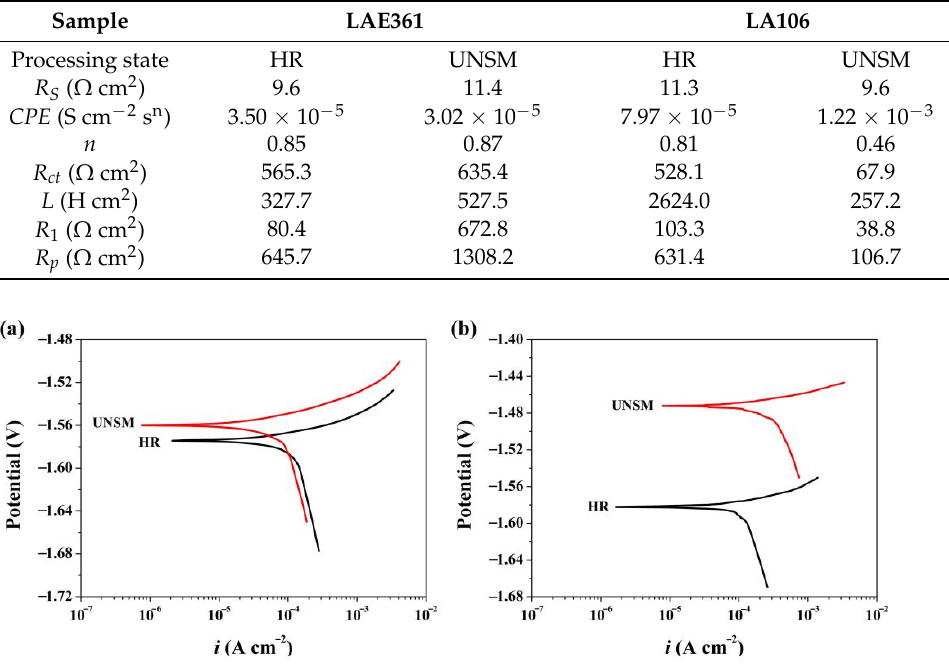
Figure 11. Nyquist plots of LAE361 Mg-Li alloy ( a ) and LA106 Mg-Li alloy ( b ) before and after the UNSM treatment in 3.5 wt.% NaCl solution at RT. Table 2. EIS parameters obtained from the fitted equivalent circuit.